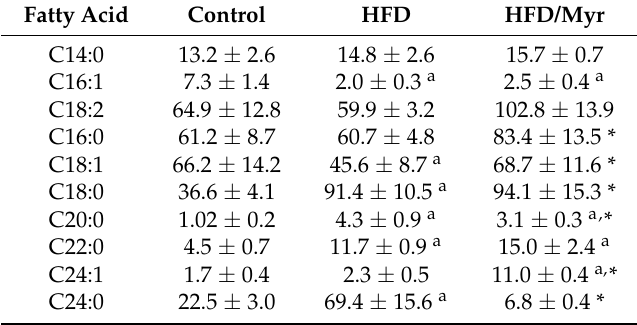
a —vs. Control; *—vs. HFD.